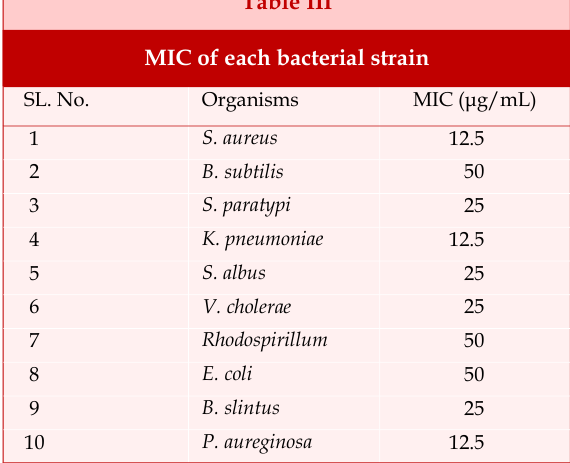
MIC of each bacterial strain